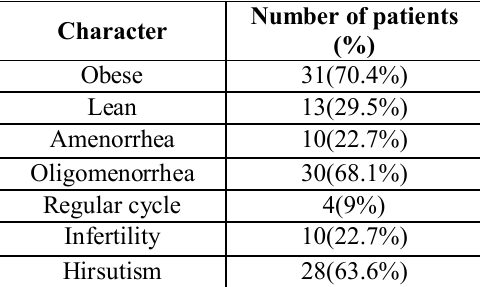
Table(1): demographic data of 44 patients with PCOS.